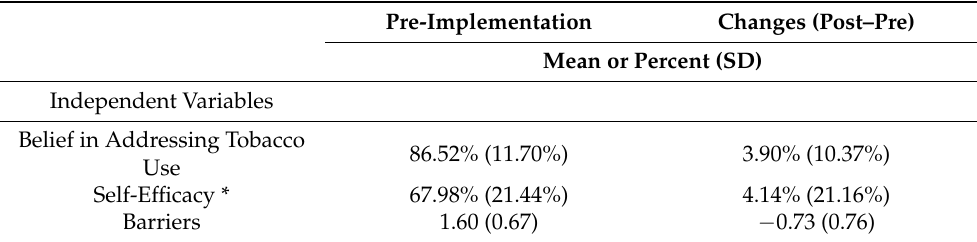
Table 1. Center-level average percentages/means of pre-implementation variables and the changes by